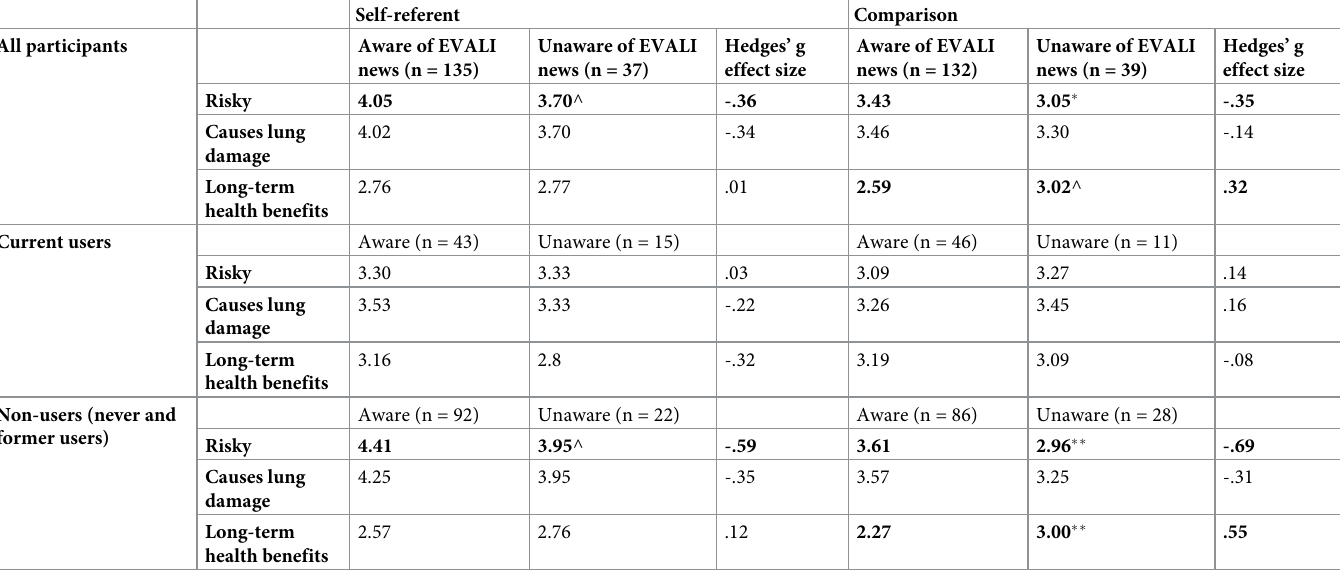
Table 4. Mean belief endorsement about e-cigarettes among participants aware and unaware of the EVALI news story by user status and wording